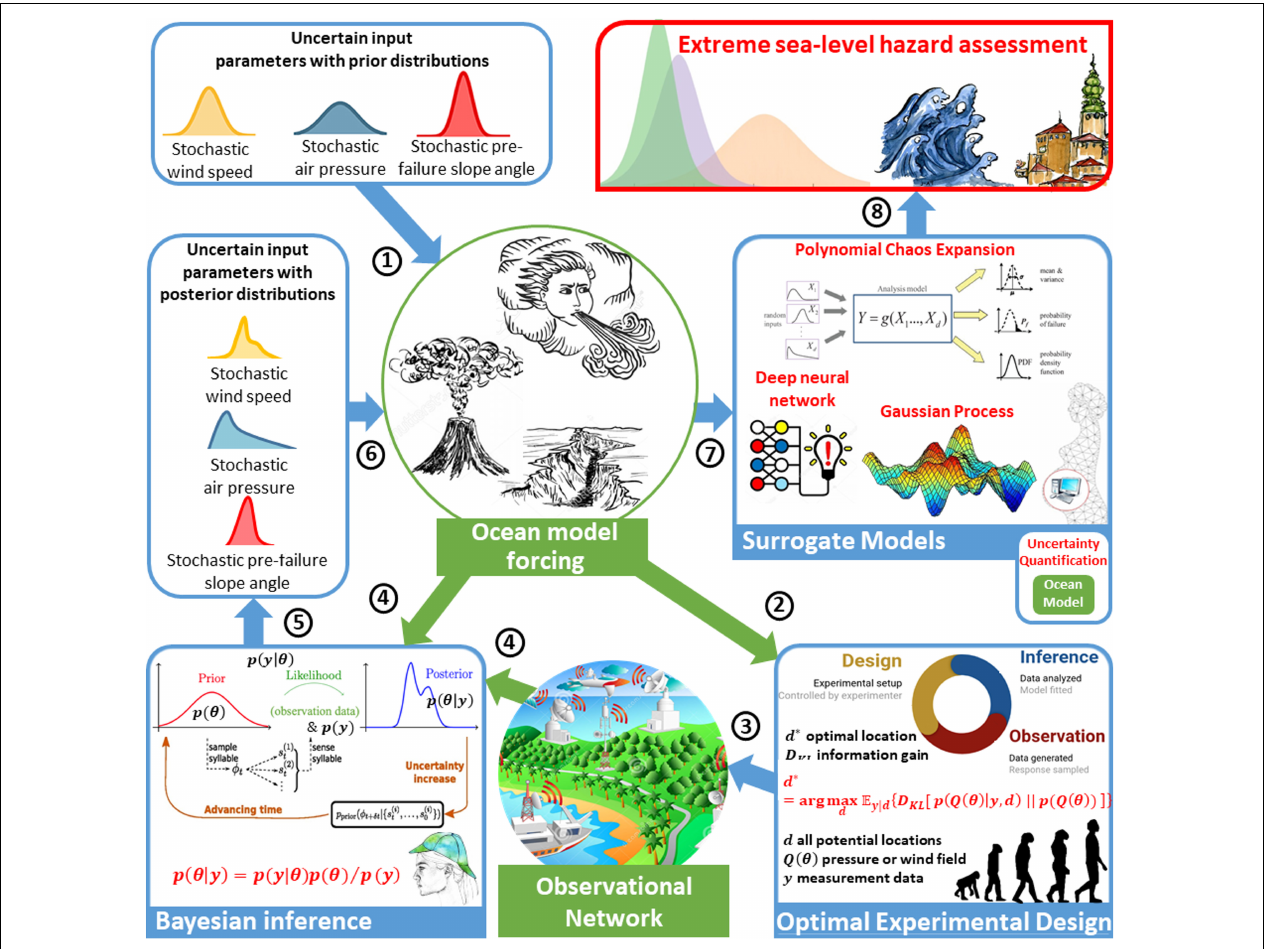
FIGURE 1 | Extreme sea-level hazard assessments based on uncertainty quantification and optimization engineering methods: (1) uncertain input parameters with prior distribution are used to create stochastic ocean model forcing which are both (2) and (3) used to optimized the observational network with optimal experimental design strategies and (4) modified with the assimilation of observational data via Bayesian inference in order to (5) create the posterior distributions of the input parameters. Finally, (6) new stochastic ocean forcing based on these parameters are used to force (7) the surrogate models and produce (8) extreme sea-level hazard assessments. Drawing of the flooded city adapted from Frits Ahlefeldt: